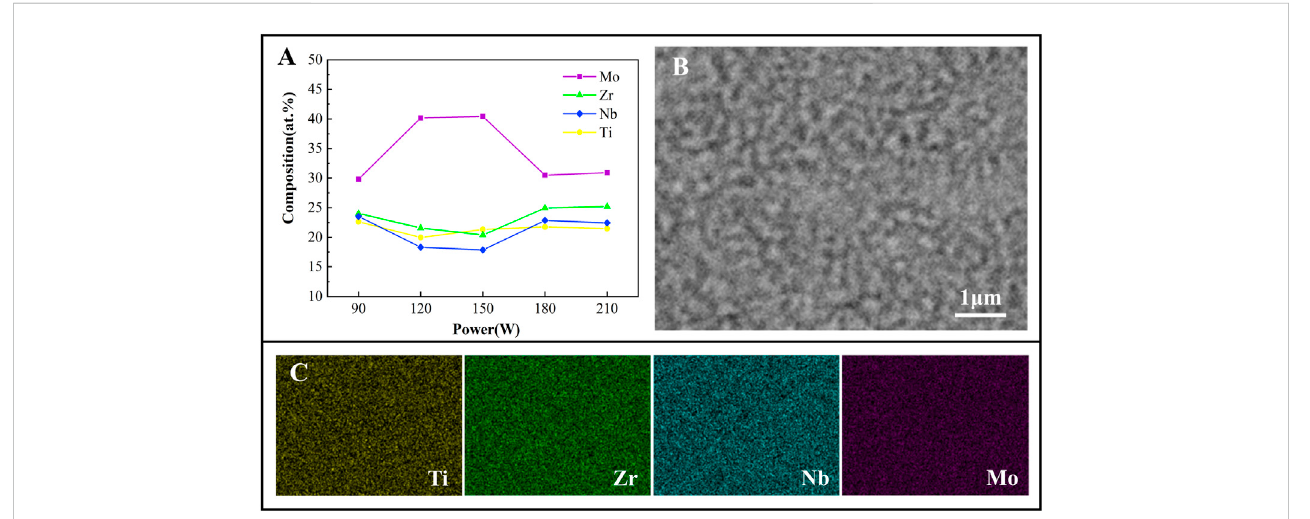
FIGURE 1 (A) Elemental concentration of the ZrNbTiMo fi lms deposited at different sputtering power, (B) SEM image, and (C) element mapping images of the top surface of the fi lm deposited at 150 W.